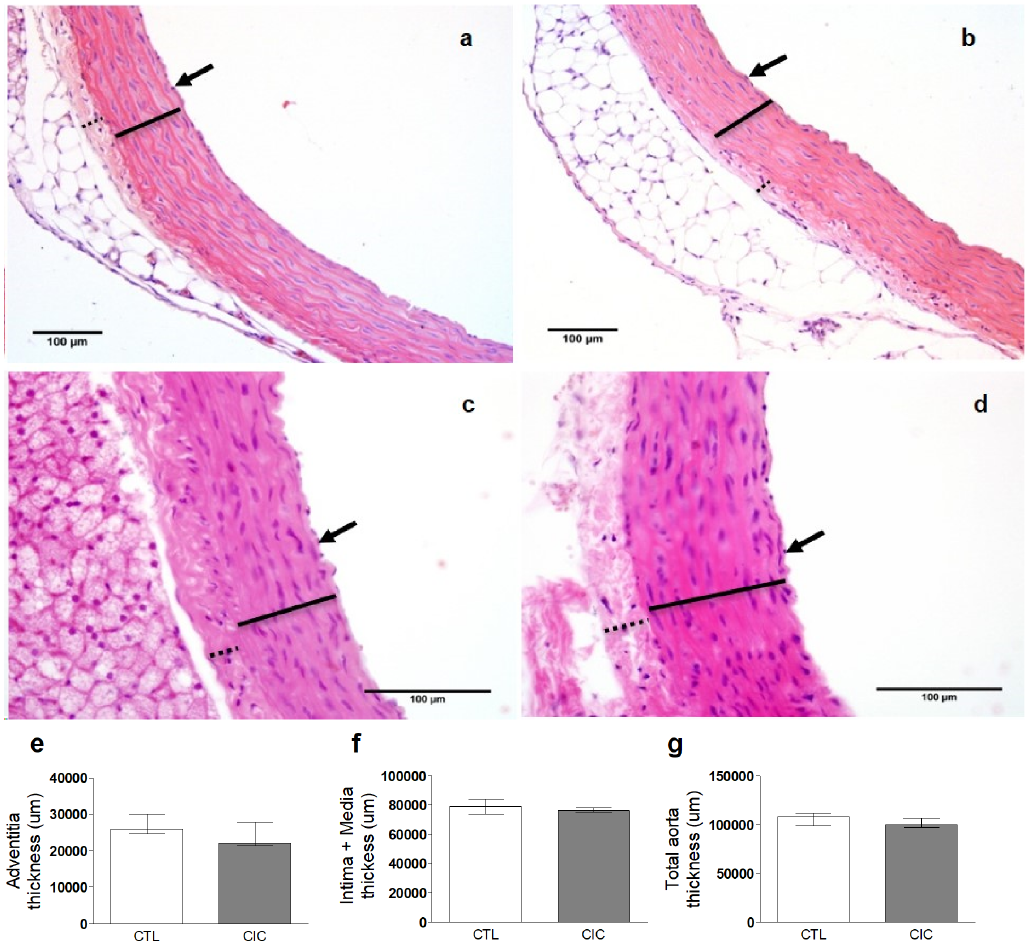
Figure 5. Morphological and morphometric analysis of aorta. Representative photomicrographs of transversal sections of aorta from CTL (a and c) and CIC (b and d) rats showing tunica intima with endothelial cells (arrow), tunica media containing muscle cells (line) and tunica adventitia formed by connective tissue (dotted line). Scale bar = 100 μm. HE staining. Morphometric evaluation of tunica adventitia thickness (e) , tunica intima and media thickness (f) and total thickness of aorta (g) from CTL (n = 6) and CIC (n = 9). Data are expressed as median and interquartile range, analyzed by Mann-Whitney U